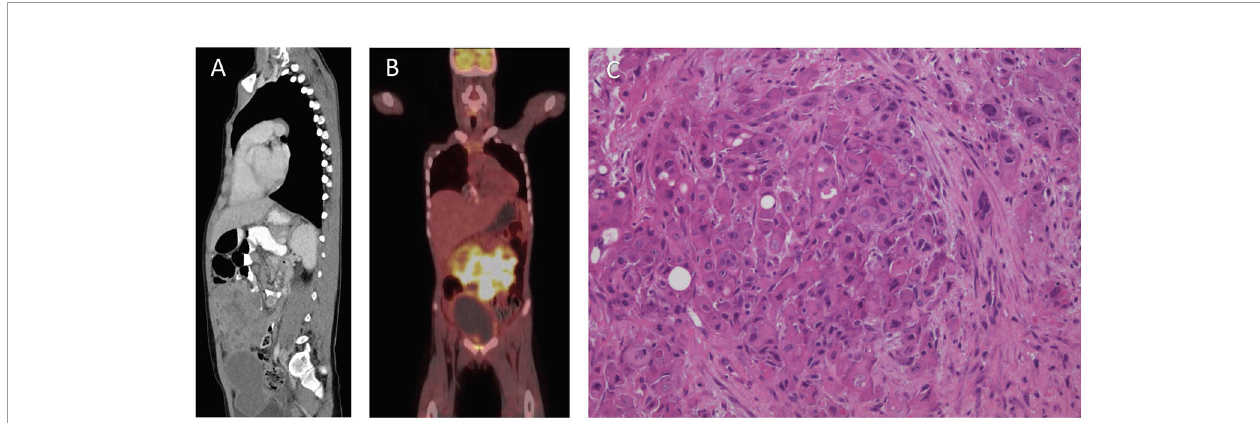
FIGURE 1 | Clinical features of patient at diagnosis. (A) Computerized Tomography scan of the abdomen and pelvis. (B) Fluorodeoxyglucose – positron emission tomography scan. (C) Hematoxylin and eosin stain, showing nests of pleomorphic epithelioid cells with occasional vacuoles and luminal